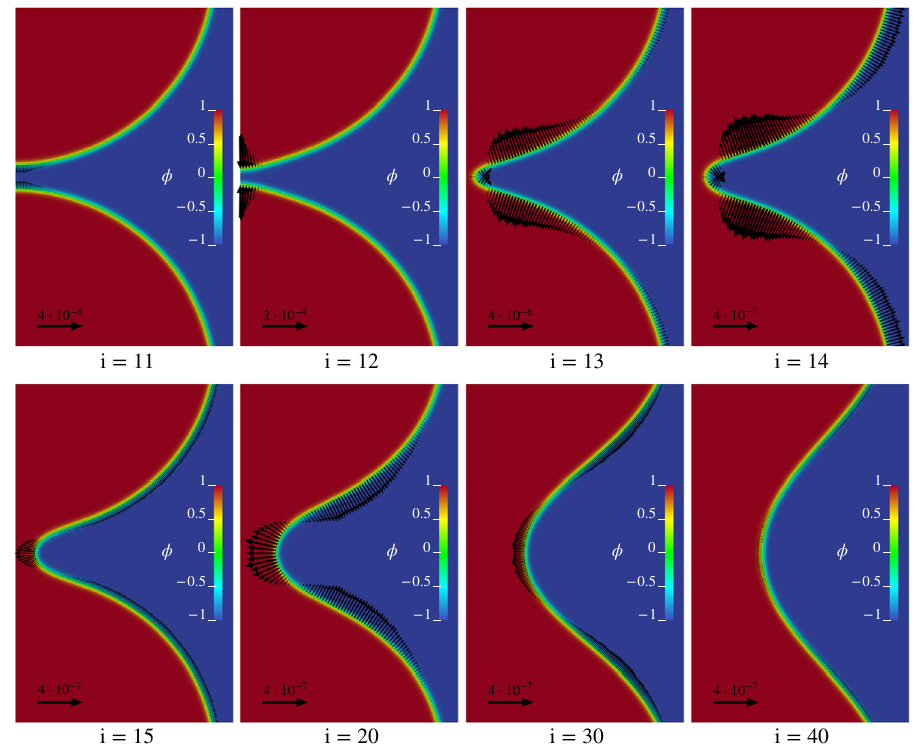
Fig. 4 Force fi elds along the MEP. Detailed views in the r * − z * plane of the vesicle con fi gurations. The index i = ( N − 1) α i + 1 numbers the images on the string. Vectors, that are plotted for clarity only on the ϕ = 0 isoline, provide the force fi eld f * required to keep the vesicle in equilibrium in the given con fi guration, balancing the internal elastic reaction. The contours depict the fi eld ϕ . For better visibility, vectors are scaled according to the reference arrow in each plot.